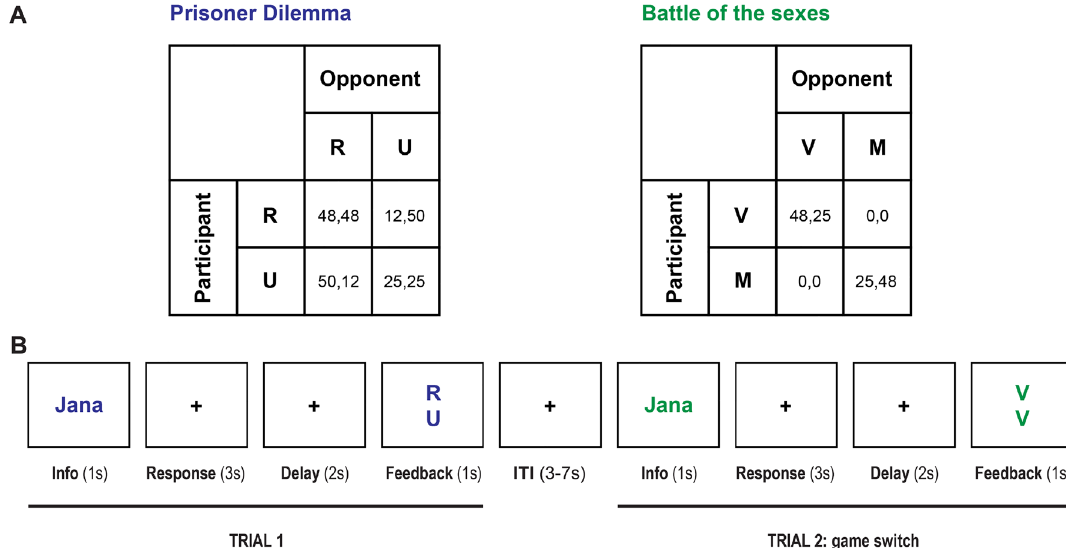
Figure 2. Experimental paradigm. ( A ) Payoff matrices for the two stage games (i.e., PD , BoS ); payoffs are displayed in experimental currency units, for each game. The response options (i.e., R/U and V/M) displayed in the table correspond to those shown in Tables 1 and 2 (i.e., Coop / Def and Best / Worst , respectively). During the experiment, letter pairs were used. The stage game was indicated by the color (i.e., blue/red for PD and green/ yellow for BoS , counterbalanced across participants). ( B ) An example of two consecutive trials in one f MRI session. In this example, the player (i.e., Jana) does not change between trials, but the stage game does (from PD to BoS ), as shown by the change of color. During the first trial, the participant chose R (i.e., Coop ) and the automaton U (i.e., Def ), while during the second trial both the participant and the automaton chose V (i.e., the participant’s favorite option). ITI inter-trial